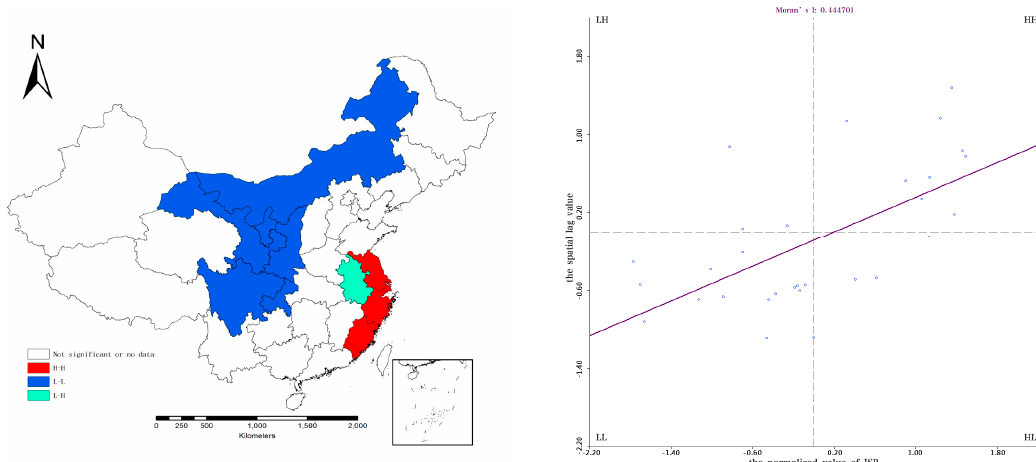
Figure 4. Moran scatter plots of ISR in 2015. The left part shows the corresponding spatial pattern, the right part shows distributions of ISR.